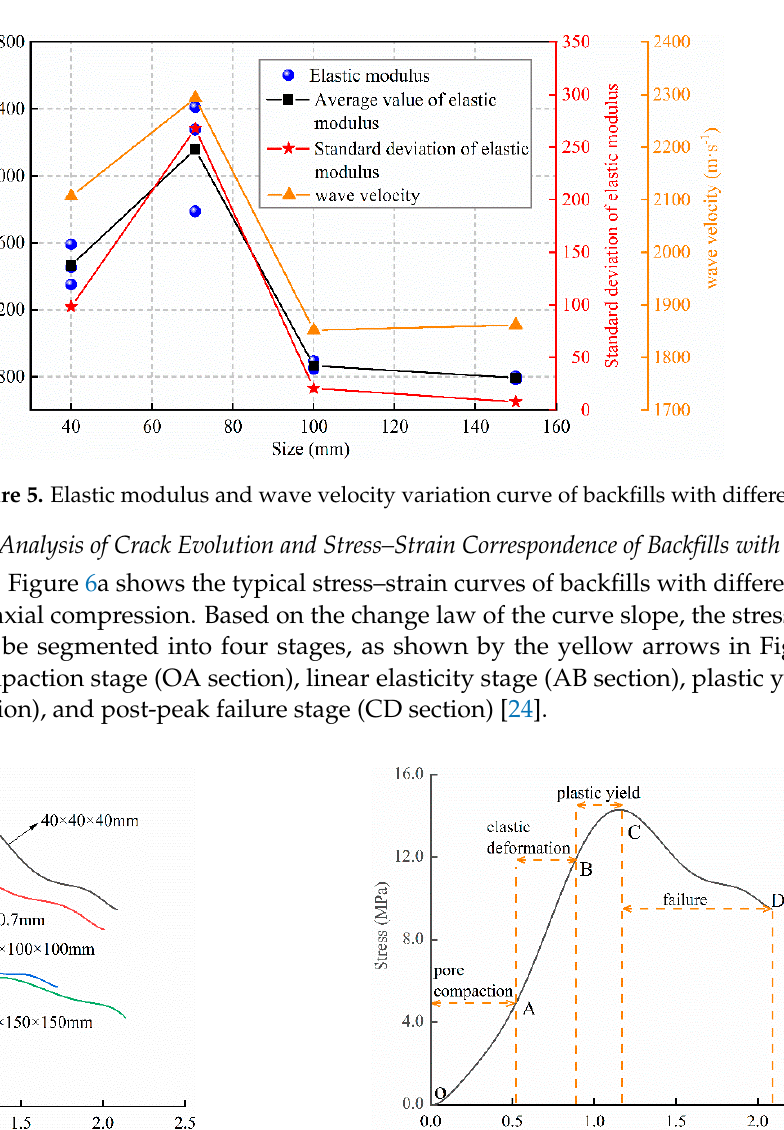
Figure 5. Elastic modulus and wave velocity variation curve of backfills with different sizes.